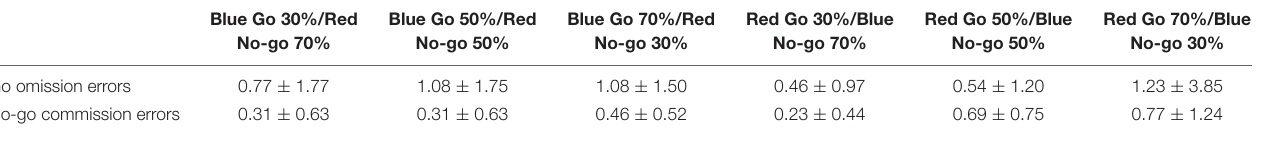
TABLE 1 | Go omission and No-go commission errors (mean ± SD).